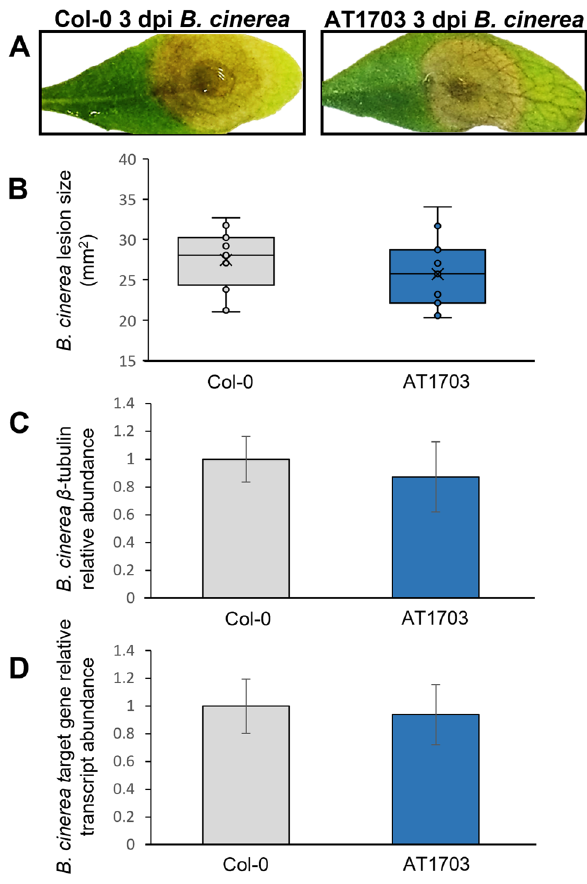
Figure 6. Lesion size (mm 2 ), fungal load and target transcript knock down in wild-type Col-0 and T3 transgenic AT1703 A. thaliana leaves infected with B. cinerea . A. thaliana inoculated with 1 × 10 6 µL ascospore solution and measured at 3 days post inoculation. ( B ) Sample size of n = 15 leaves per line were measured using ImageJ software and normalized to wild-type Col-0 leaves for lesion measurements. Error bars represent standard error and significance was determined using a Student’s t -test (p < 0.05). ( C ) Fungal load quantified using relative abundance of B. cinerea β–tubulin and calculated using ∆CT against wild-type Col-0. Each line consists of three biological replicates, each containing three infected A. thaliana leaves. ( D ) Target transcript knockdown calculated using the ∆∆CT method with β–tubulin as a reference gene. Each line consists of three biological replicates, each containing three infected A. thaliana leaves for ( C) and ( D ). Error bars represent standard